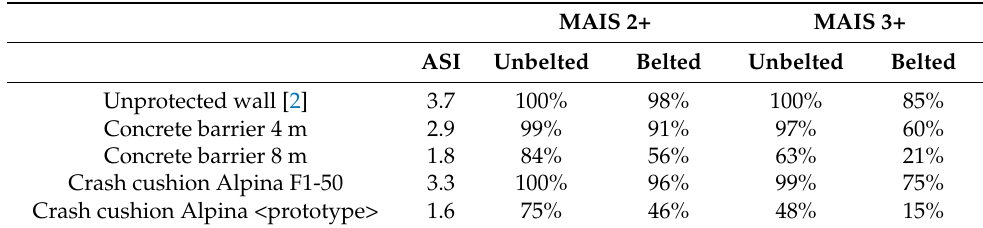
Table 8. Corresponding risk of MAIS 2+ and MAIS 3+ [56] injuries of unbelted and belted occupants related to the THIV of the different safety